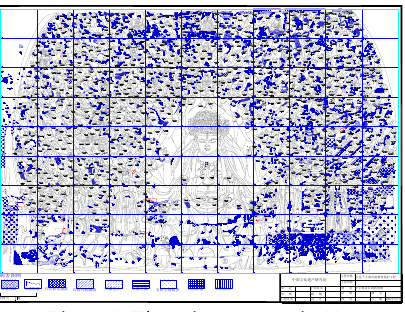
Figure 7. The Disease Area in